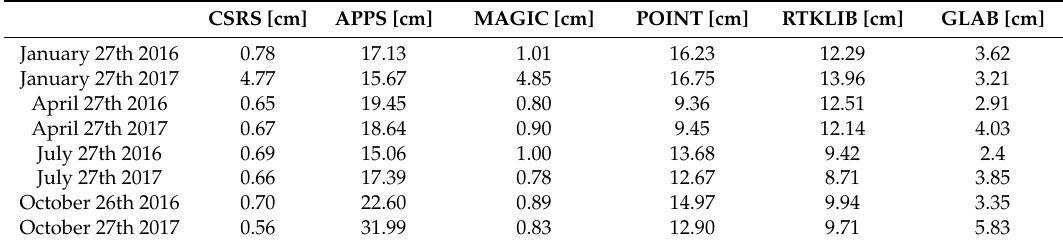
Table 7. RMSE values in centimeters for each software using all